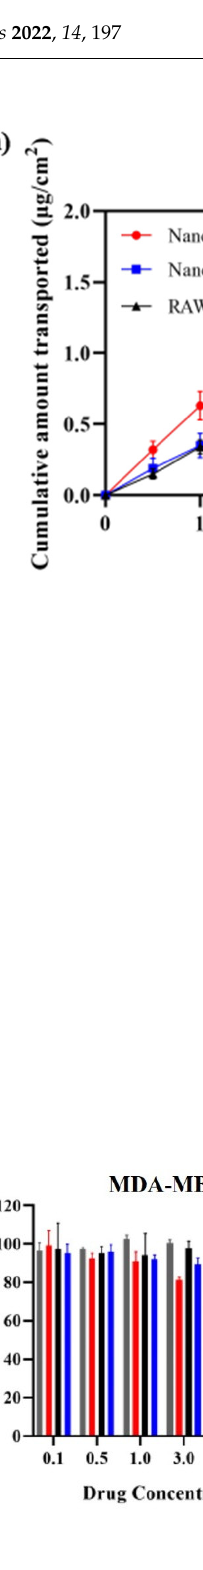
Figure 13. Cell inhabitation rates of the different samples against tumor